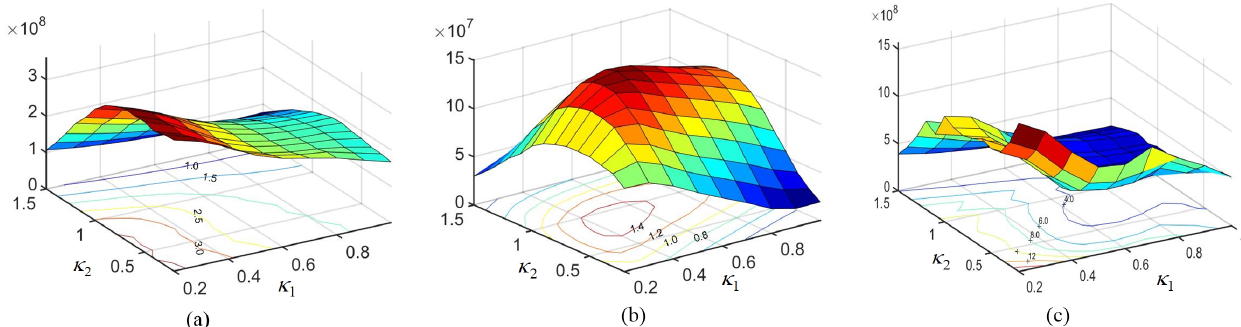
Figure 17. Performance with respect to κ 1 and κ 2 : (a) workspace volume, (b) transmission, (c) normalized reaction force.